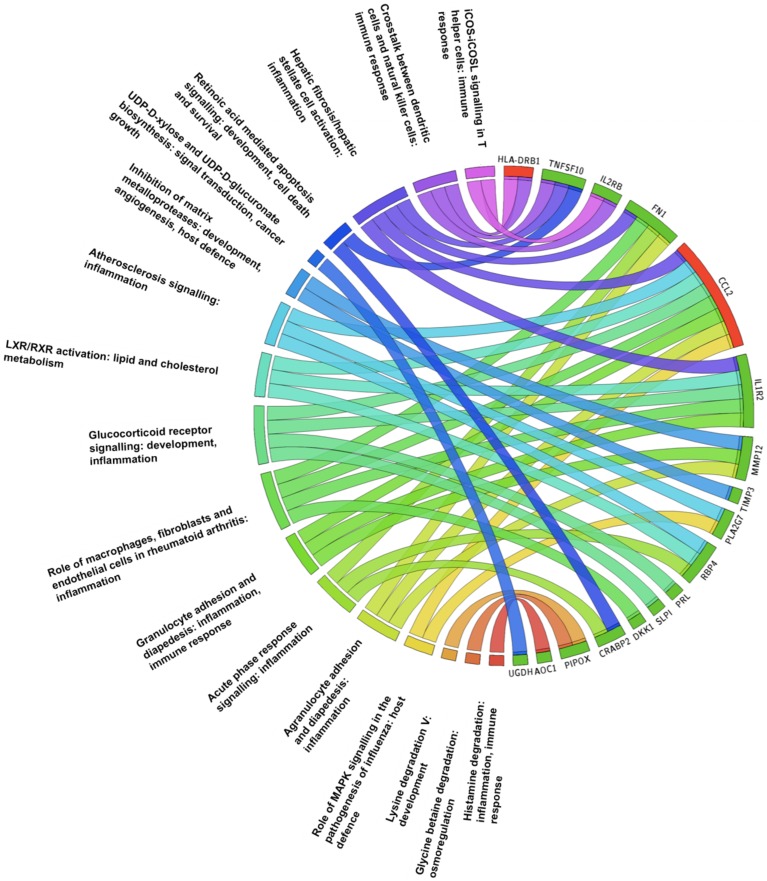
The Circos plot represents significantly enriched pathways associated with regulated genes in the placentae of obese women vs. normal weight women, detected using the Ingenuity Pathway Analysis library of canonical pathways.Outside the circle dysregulated genes and IPA pathways together with biological process are indicated. All genes are down-regulated (highlighted in green), except for HLA-DRB1 and CCL2 genes that are up-regulated (highlighted in red).